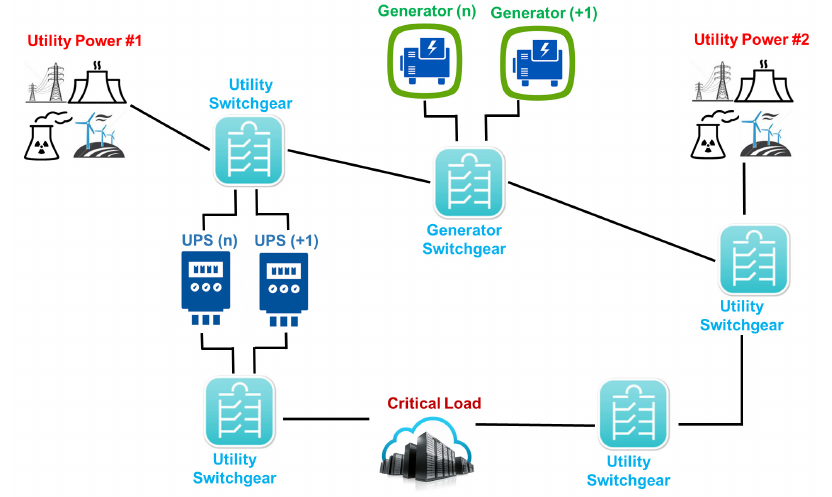
Figure 3. Tier III power system from utility to IT